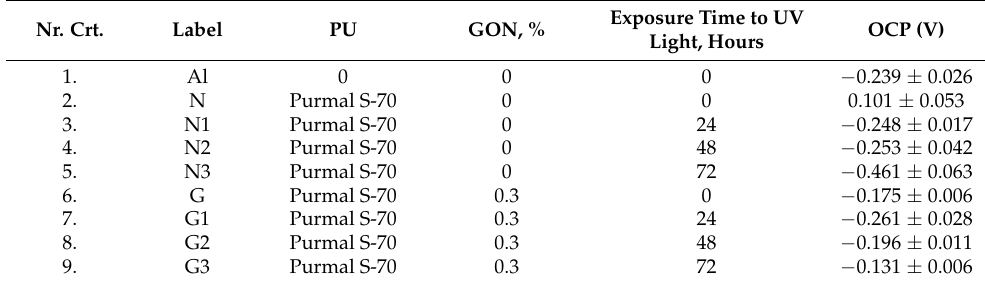
Table 3. List of prepared and analysed samples. Nr.